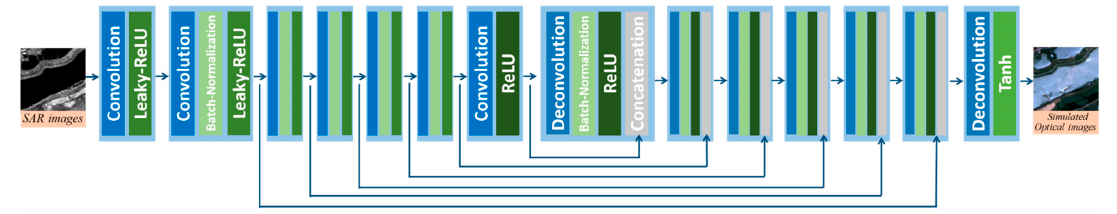
Figure 2. Structure of the Simulation network.